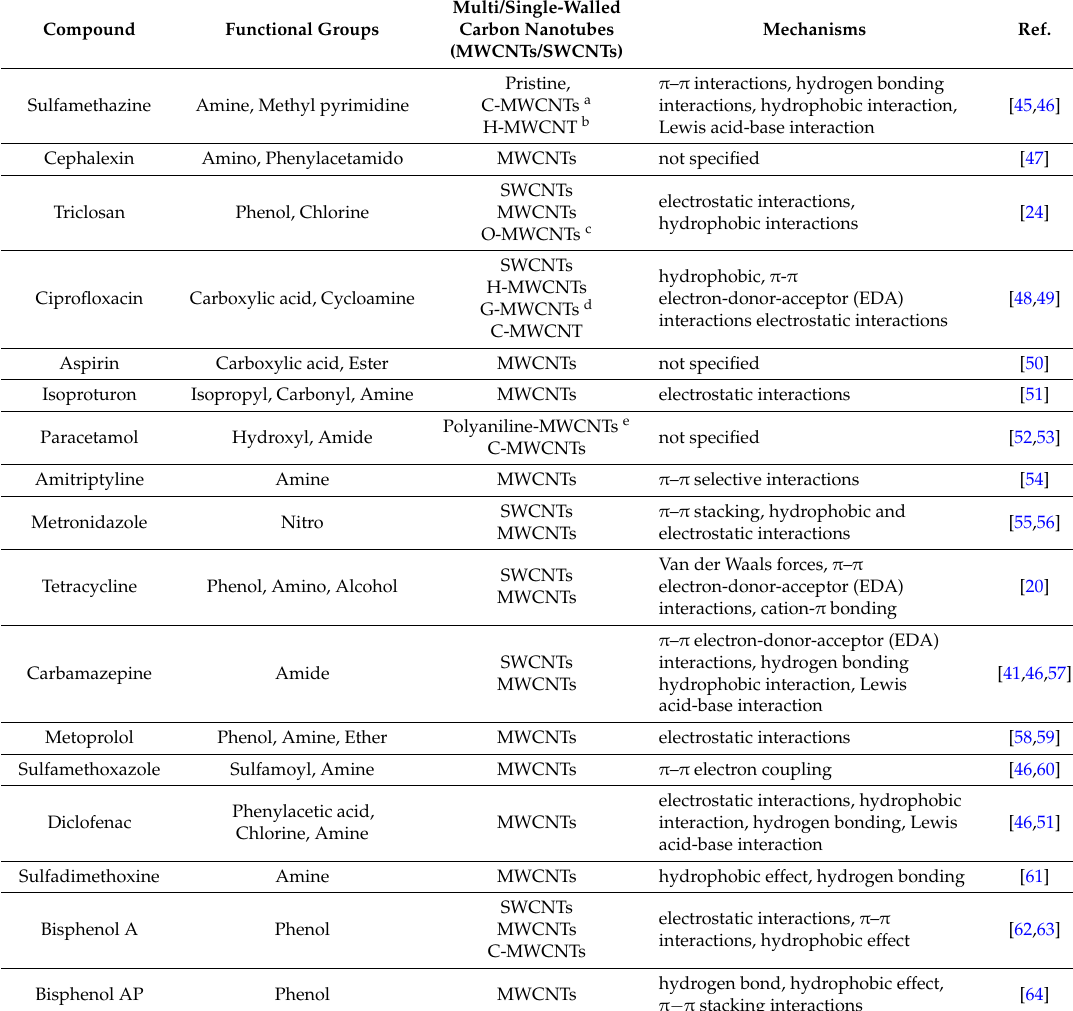
Table 1. Summary of the adsorption of emerging ionizable contaminants on carbon nanotubes (CNTs). Multi/Single-Walled Compound Functional Groups Carbon Nanotubes